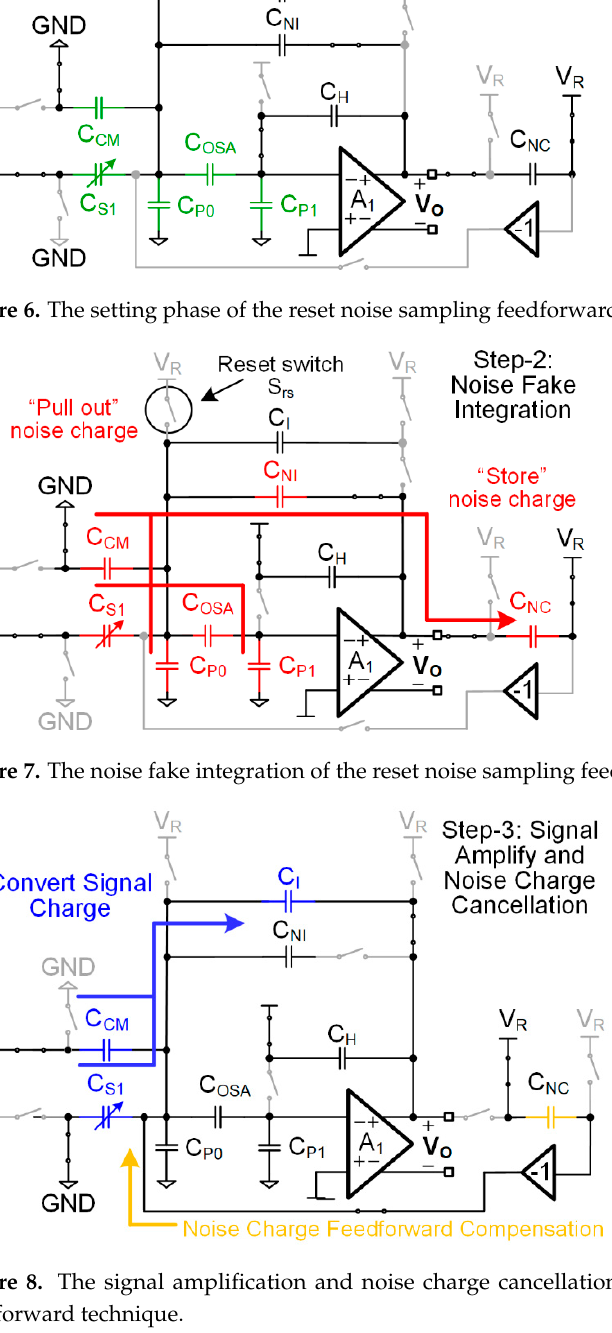
Figure 8. The signal amplification and noise charge cancellation phase of reset noise sampling feed- forward technique.